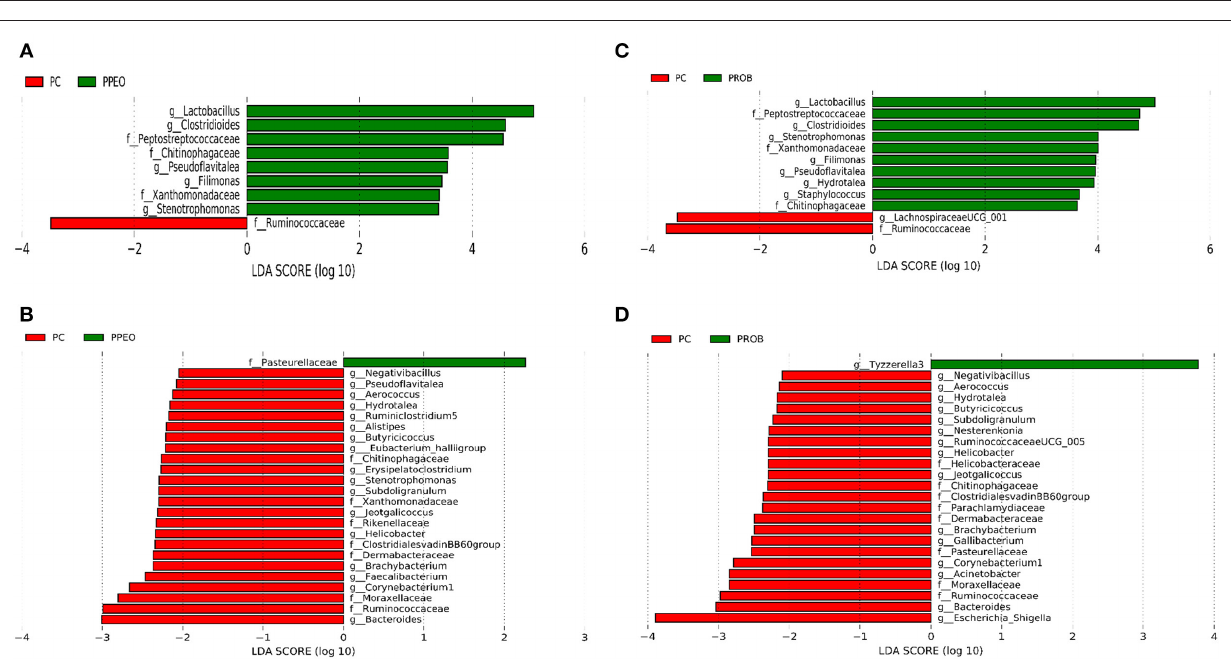
Frontiers in Veterinary Science |